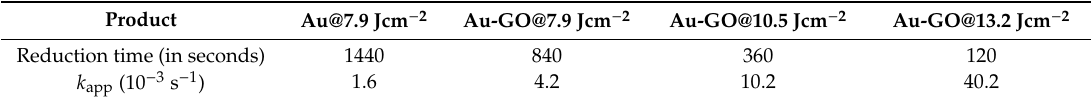
Table 1. Catalytic reduction time and k app of AuNPs and Au-GO nano-hybrids.